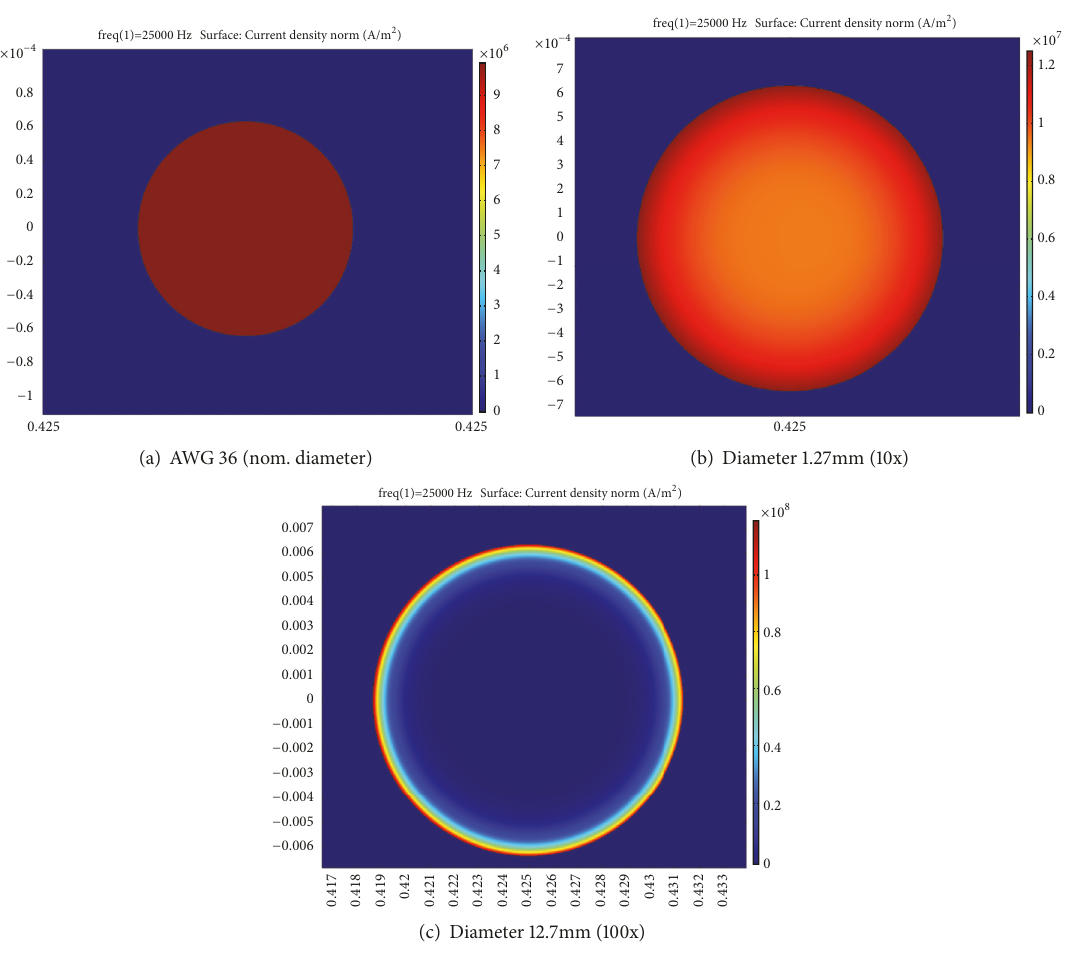
Figure 5: Current density of single strand wires fed at a 25 KHz, comparison between different diameters (FEM simulations performed with Comsol Multiphisics (cid:2) ). Table 3: Proposed coils